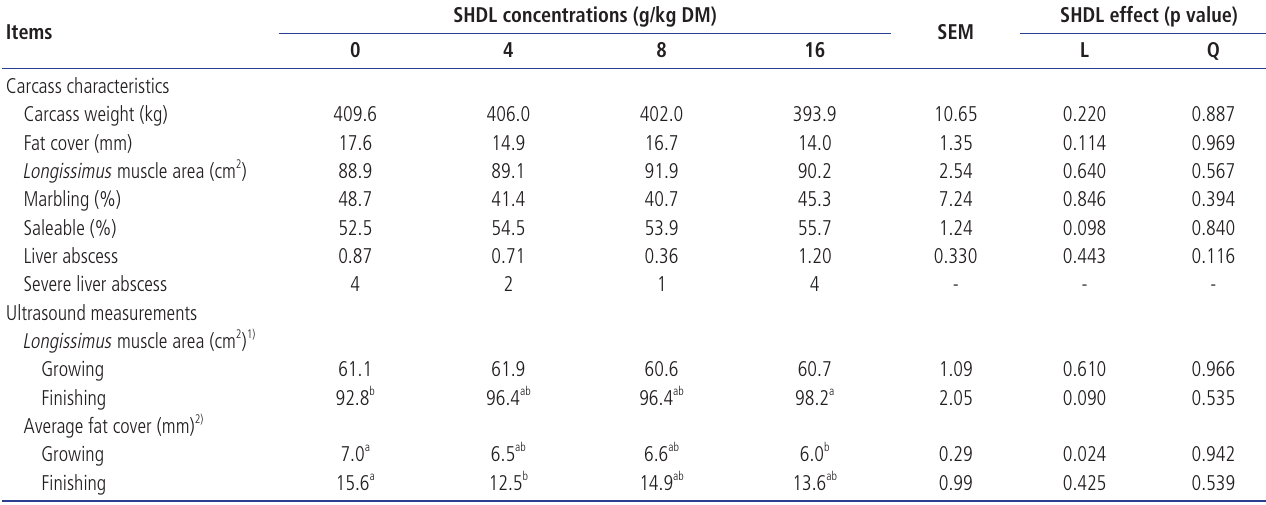
Table 6. Effects of sodium hydroxide dehydrated lignin (SHDL) on the carcass traits of feedlot steers fed barley grain - barley silage growing and finishing diets (n = 15)